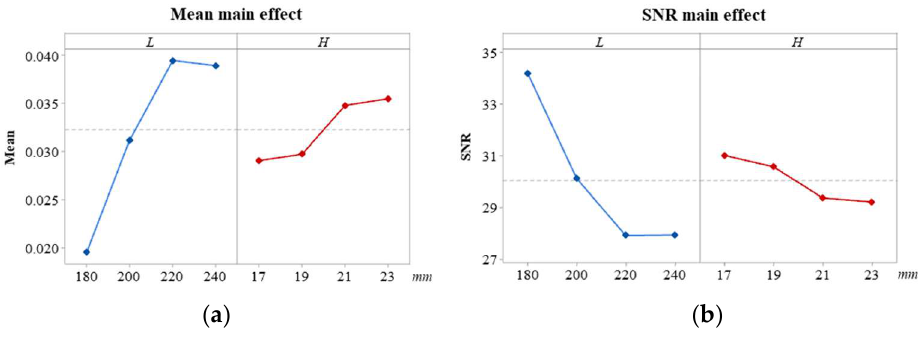
Figure 4. ( a ) Mean main effect; ( b ) SNR main effect.